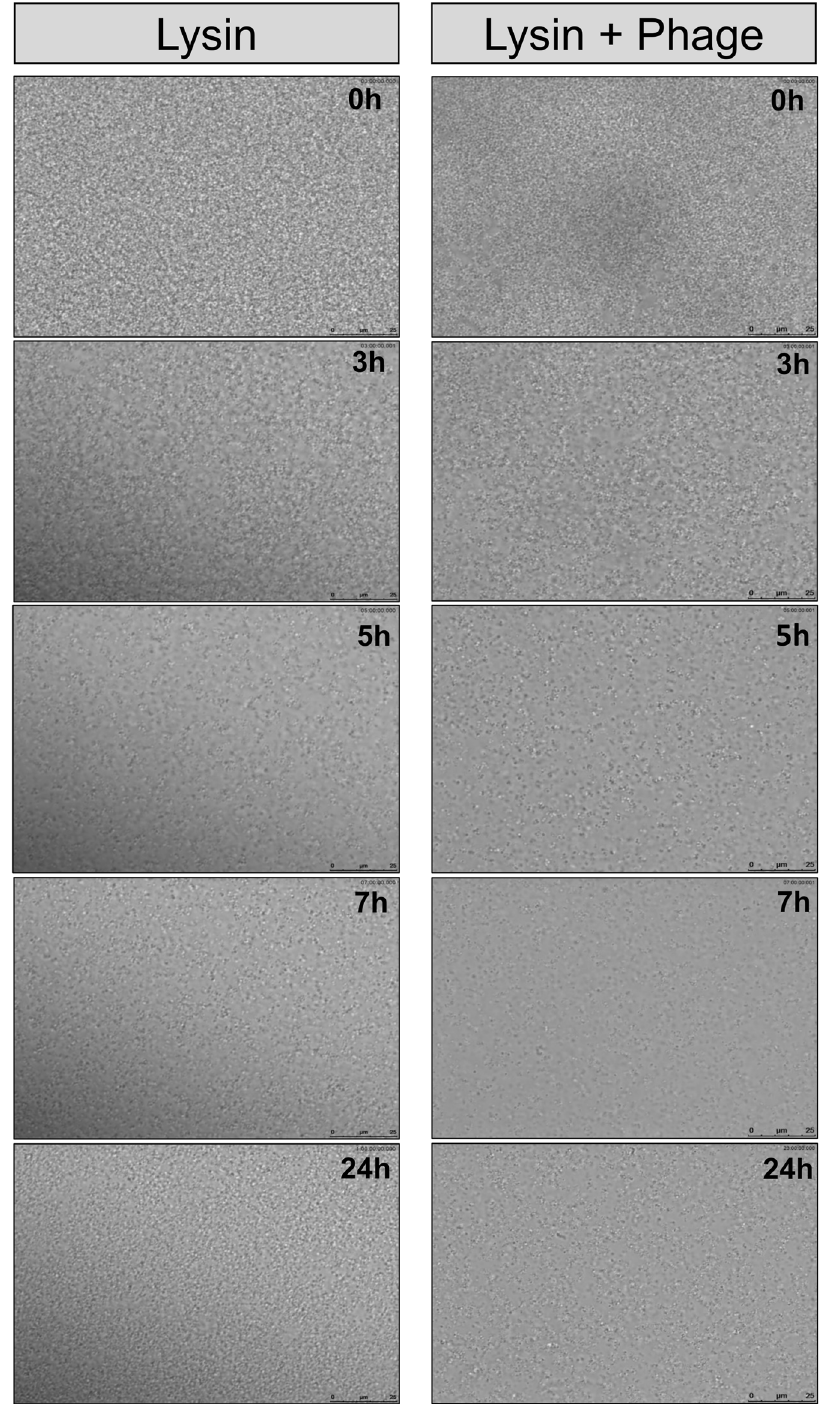
Fig. 4 Time-lapse microscopy of S. aureus V329 bio fi lms subjected to different treatments. Time-lapse microscopy of 24-h-old S. aureus V329 bio fi lms treated with CHAPSH3b (8 µM) (left) or CHAPSH3b (8 µM) + phage phiIPLA-RODI (10 9 PFU/ml) (right) during 24 h at 37